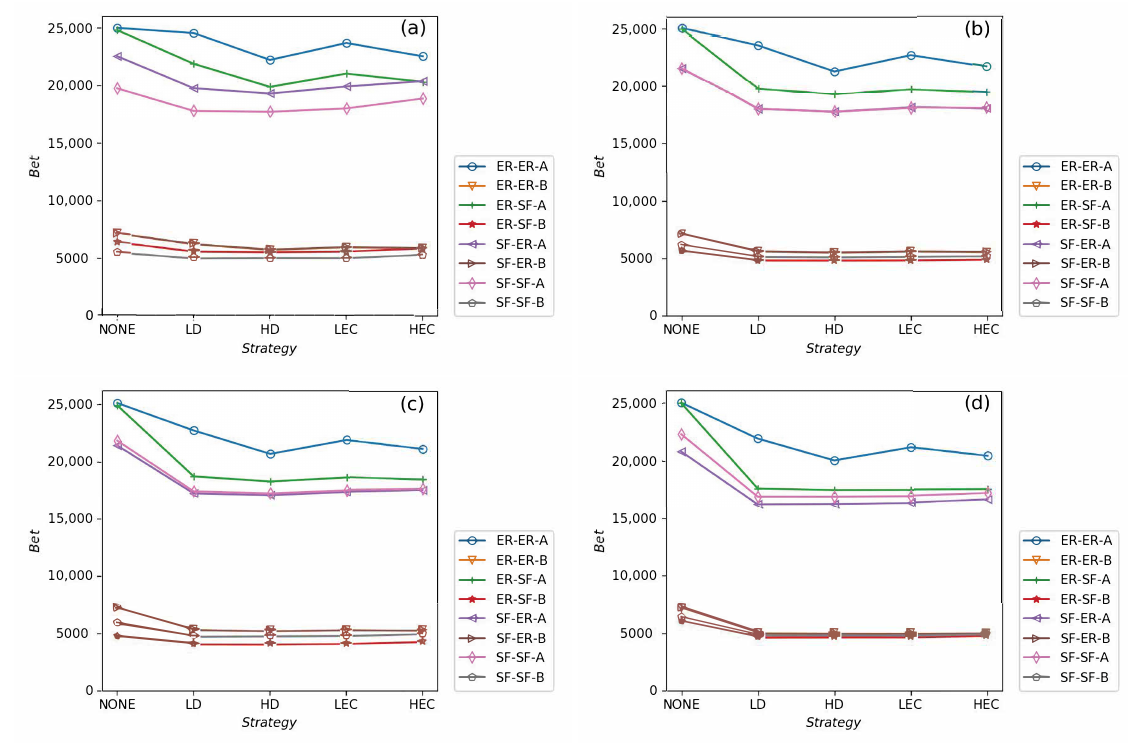
Figure 7. The values of betweenness centrality values in systems when f L = 15%, f L = 25%, f L = 35% and f L = 45% are shown in ( a – d ), respectively.